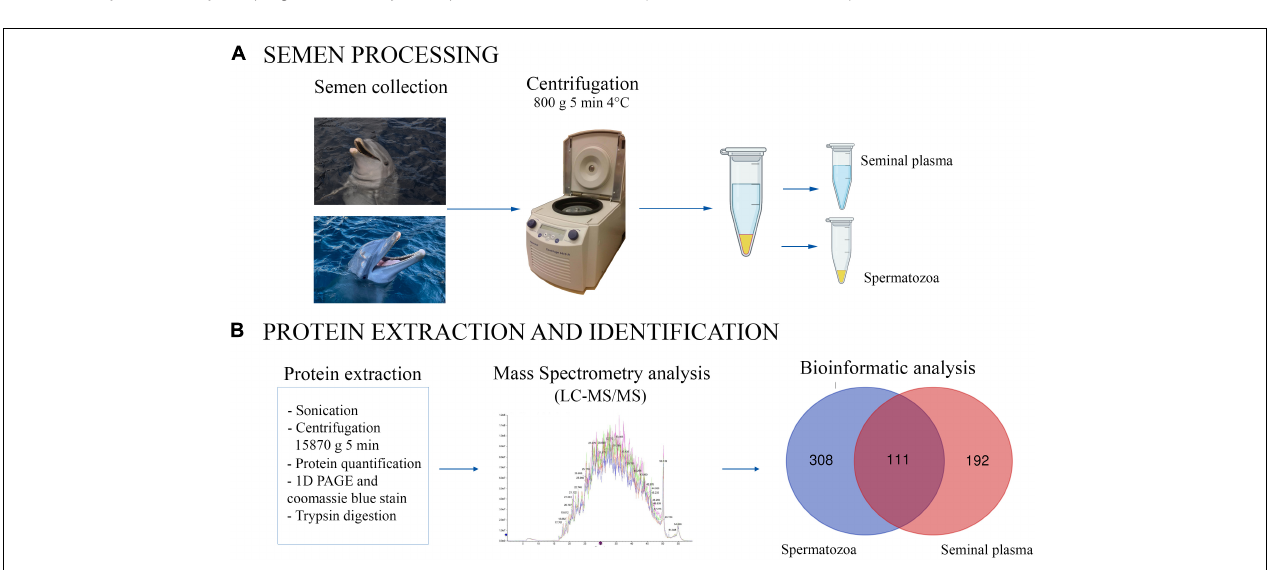
FIGURE 1 | Graphical representation of experimental process for bottlenose dolphin semen processing (A) and protein extraction and identification (B) . The Venn diagram shows the proteins found to be common (or not) to seminal plasma and